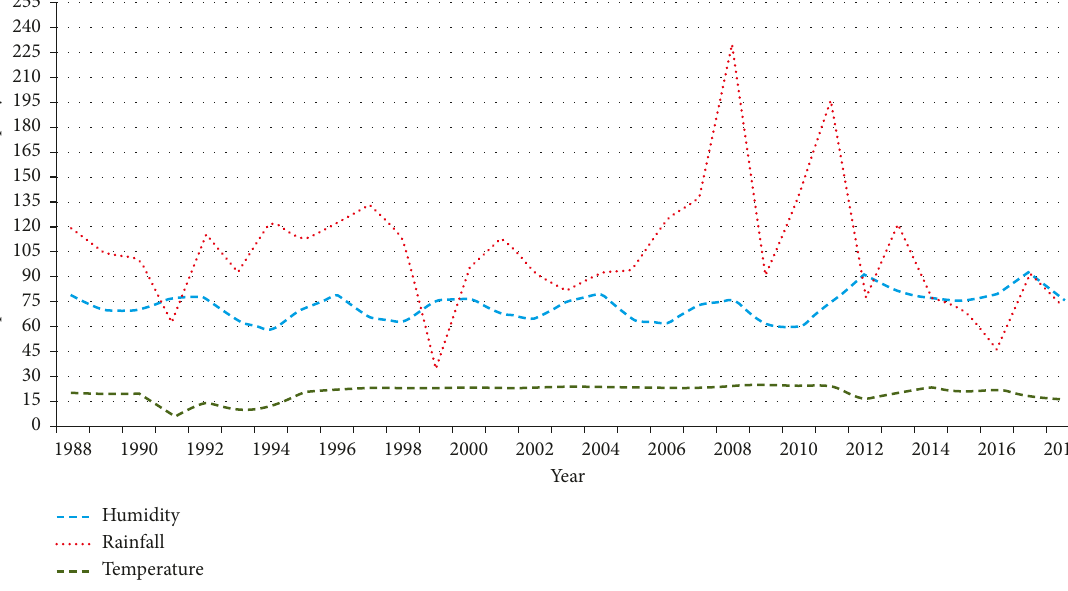
Figure 7: Annual average humidity at 12: 00 local time per month, temperature, and rainfall data per year at all stations. Source (National Meteorological Agency AA).